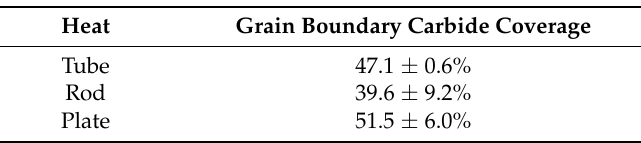
Table 5. Measured grain boundary carbide